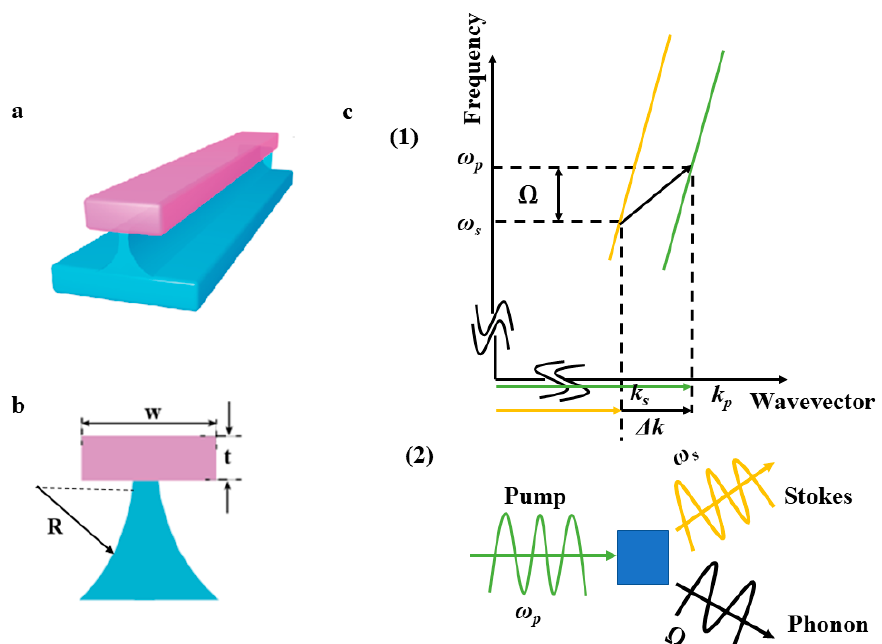
Figure 2. ( a ) Schematic diagram of the suspended waveguide system; ( b ) Design drawing of sus- pended waveguide; t = 230 nm, w = 1.5 µm, SiO 2 radius corresponds to R = 762.5 nm. ( c ) (1) Schematic diagram of the optical dispersion diagram. Optical resonance is represented by discrete points (red and blue) along the overall dispersion curve (solid line). In the figure, k s and k p represent the wave vectors of stoke light and pump light, respectively. ω s , ω p and Ω represent Stokes light, pump light and generated phonon frequencies, respectively. (2) Schematic diagram of the conversion of pump light to Stokes light and phonons.